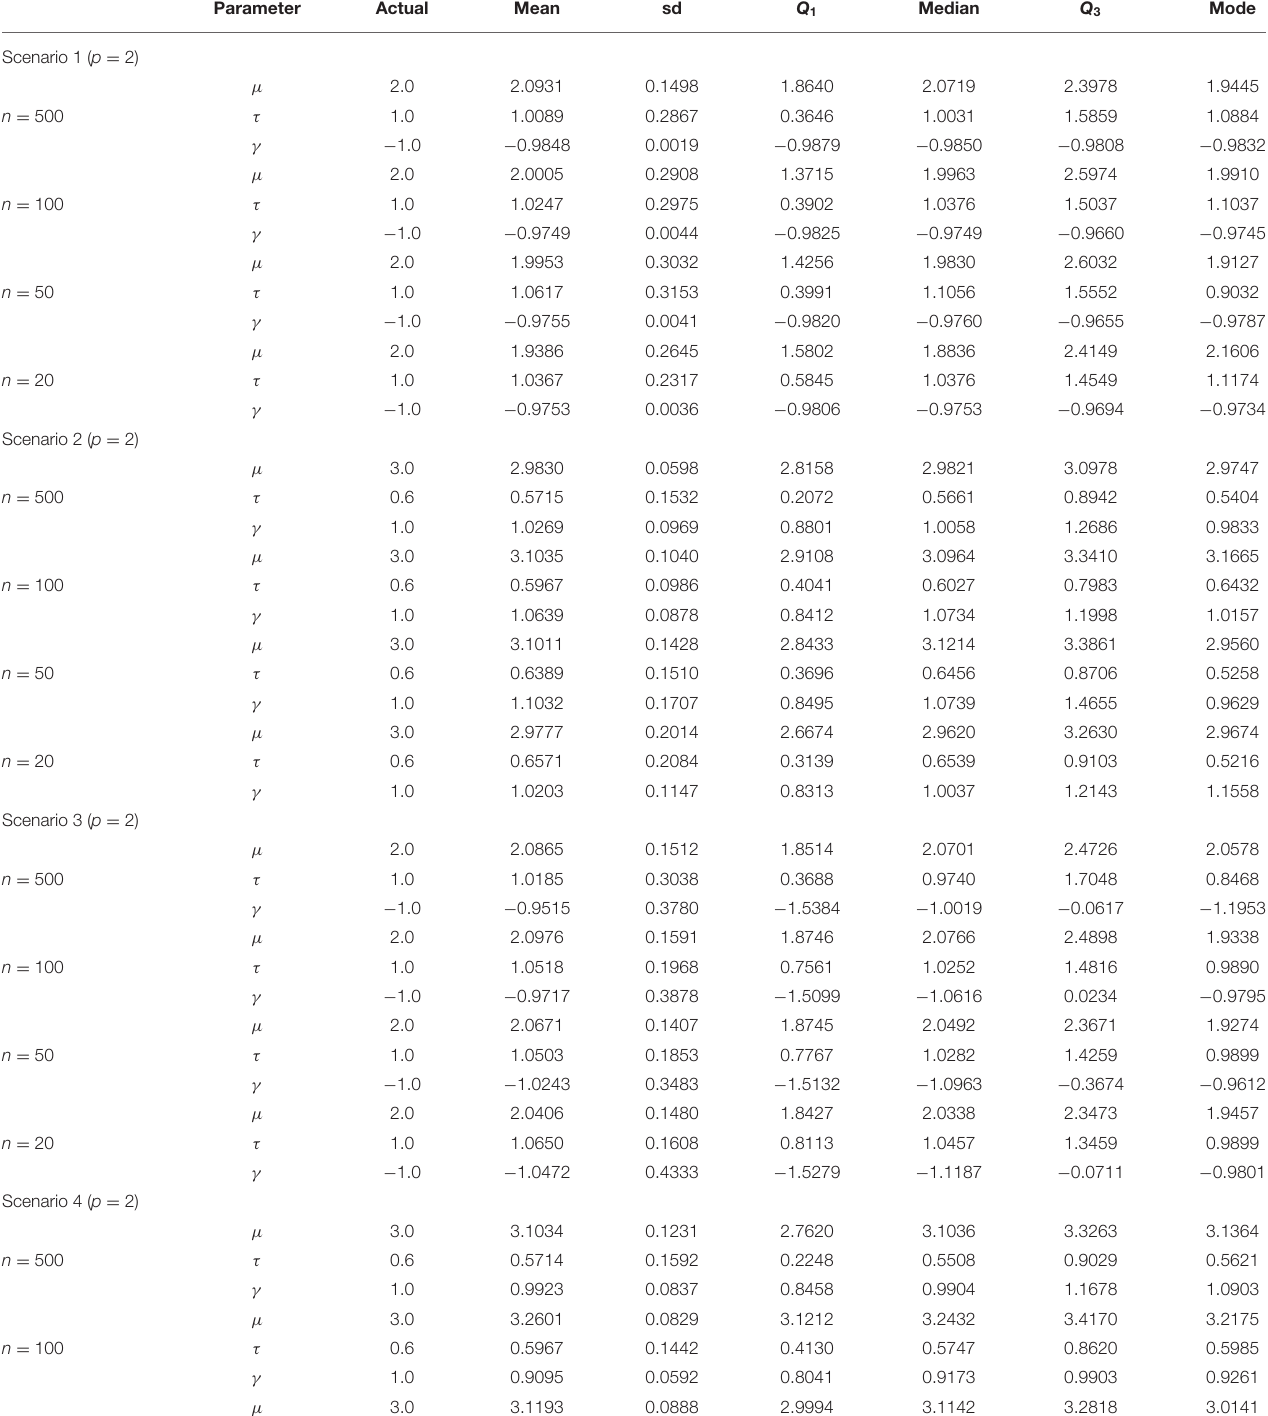
TABLE 1 | Bayes estimates of parameters for p parameters µ 0 parameters µ 0 µ